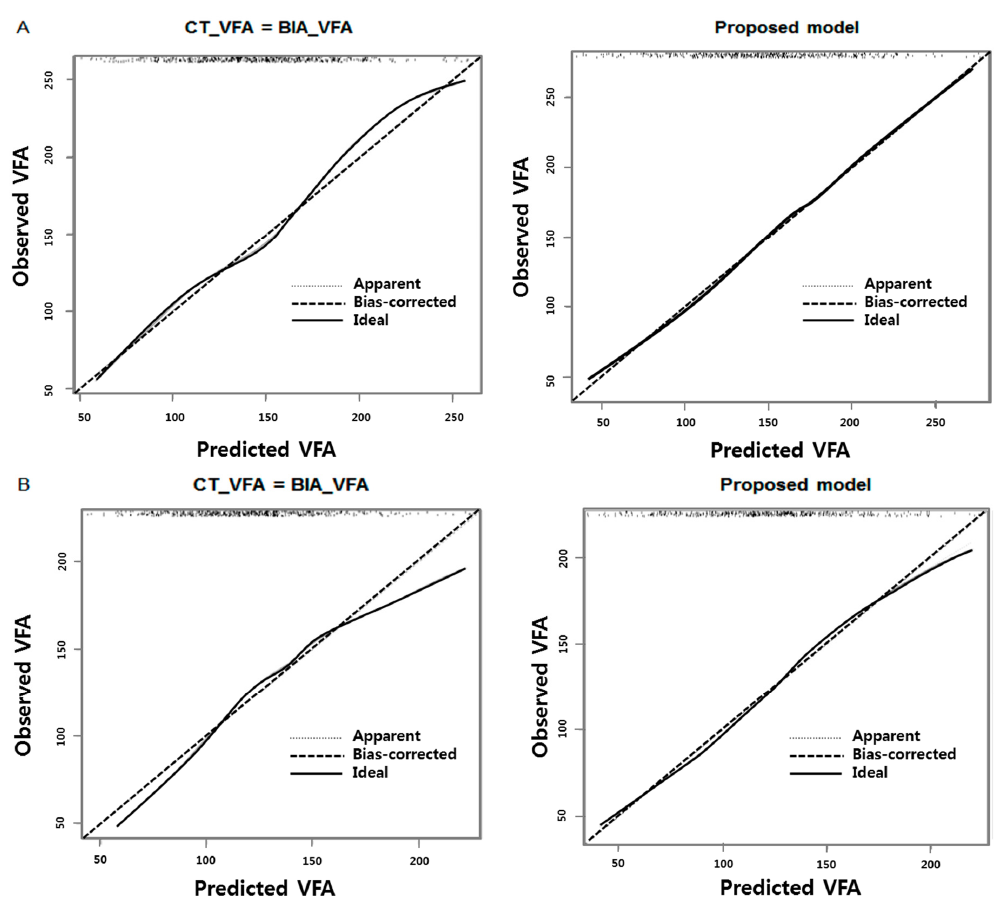
Figure 3. Calibration plots of prediction model in men ( A ) and women ( B ).